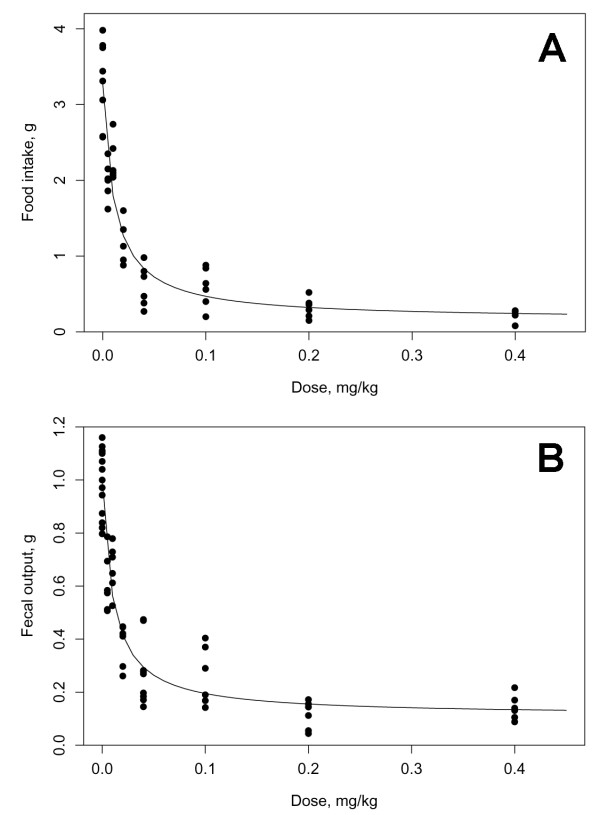
Effect of endotoxin dose on food intake and fecal output. Twelve hour food intake and fecal output was monitored over a 4 day period after injection of carrier or various doses of endotoxin. The fitted dose-response curves for food intake (A) and fecal output (B) for the first 12 hours after endotoxin injection are shown (n = 6 mice per dose).